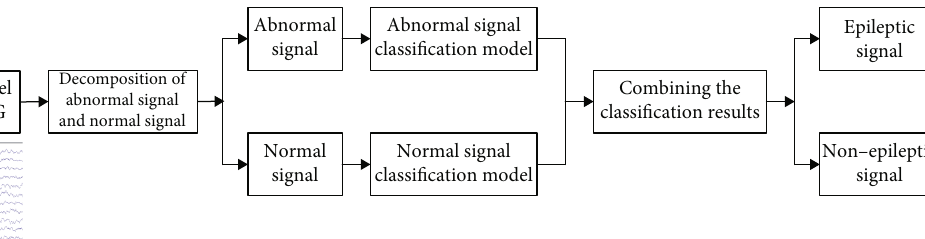
Figure 1: Structural diagram of epilepsy detection.